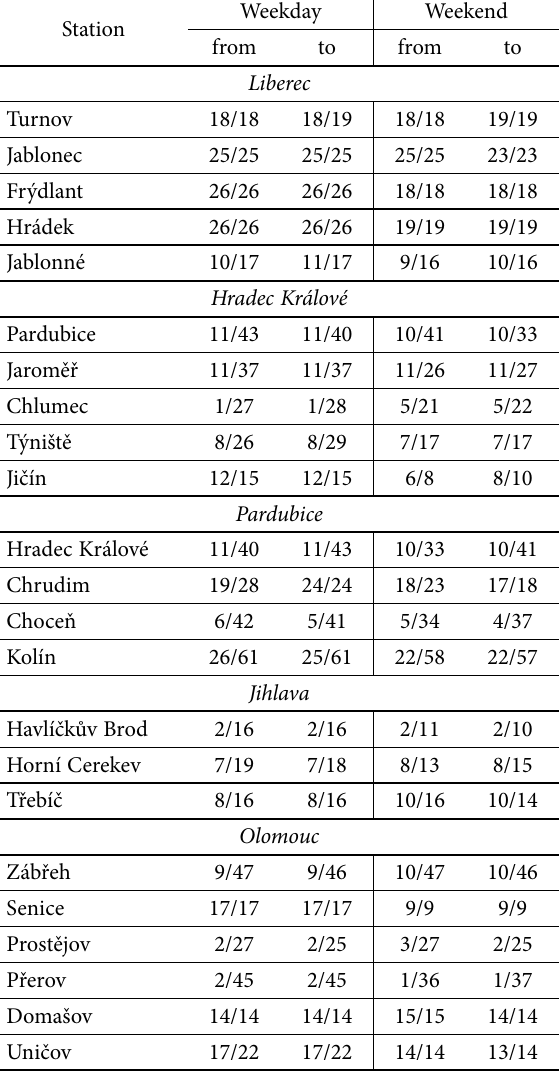
Table 2. Proportion of accessible trains in the Czech